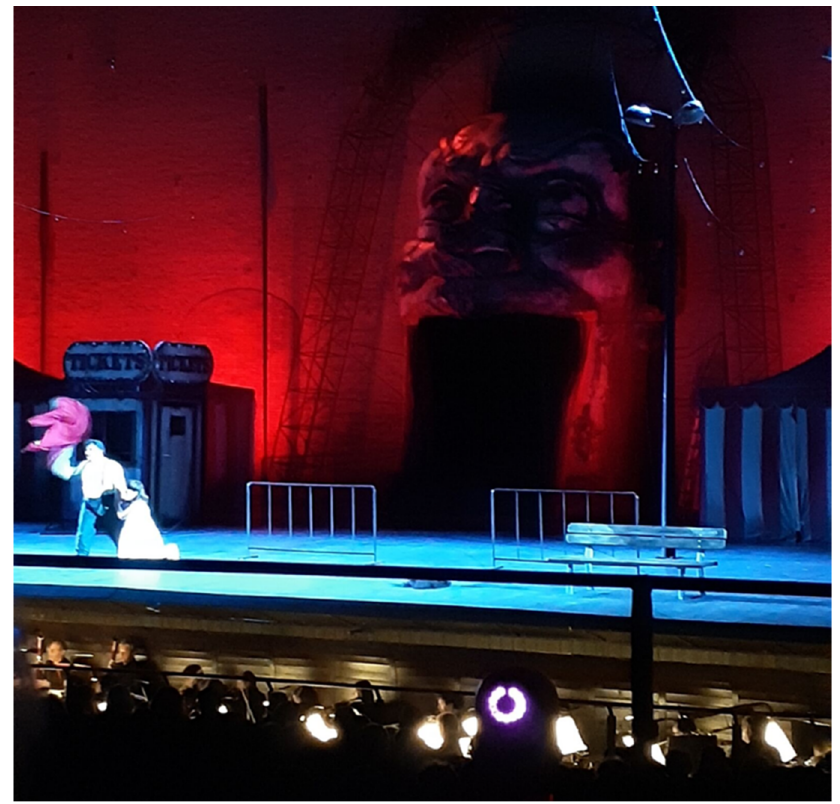
Figure 2. The IP Camera used to record the viewers’ faces during the performance.